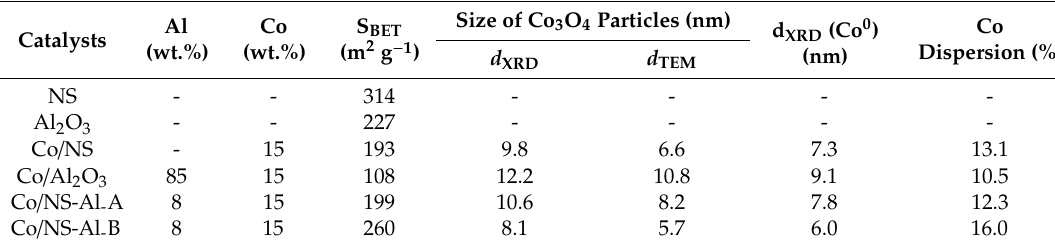
Table 1. Surface area (S BET ) of calcined